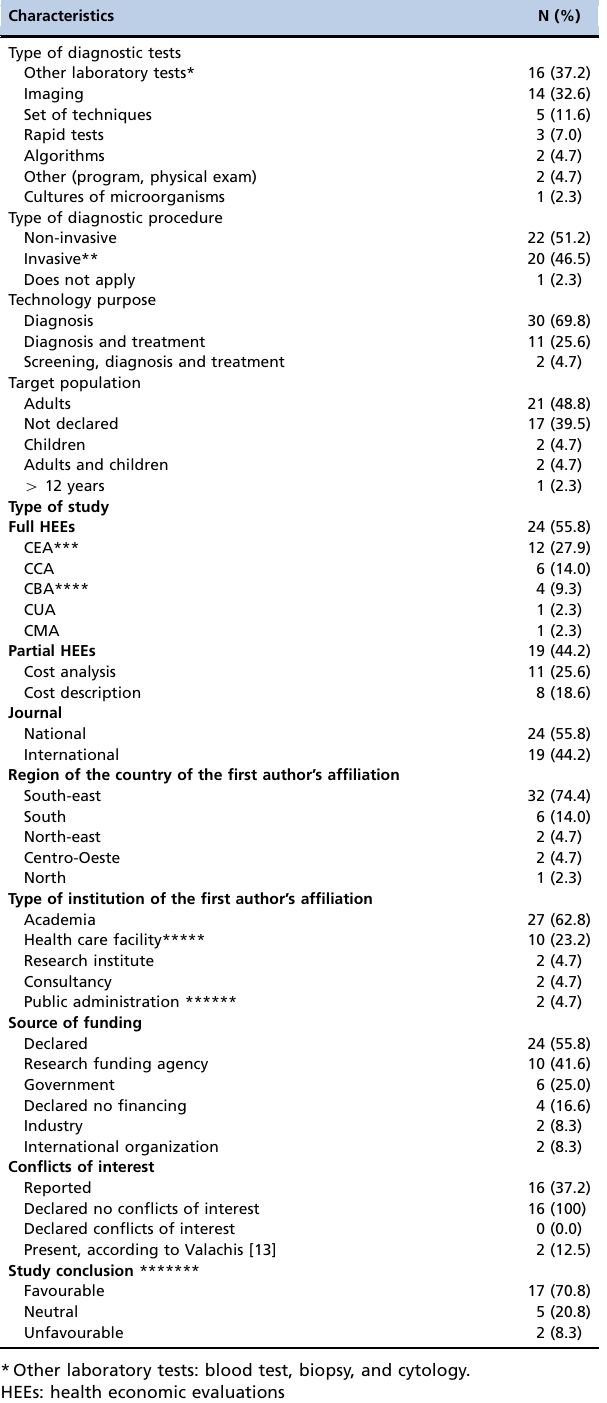
Table 1 - General characteristics of HEEs related to diagnostic tests conducted in Brazil, 1980-2013 (n = 43).